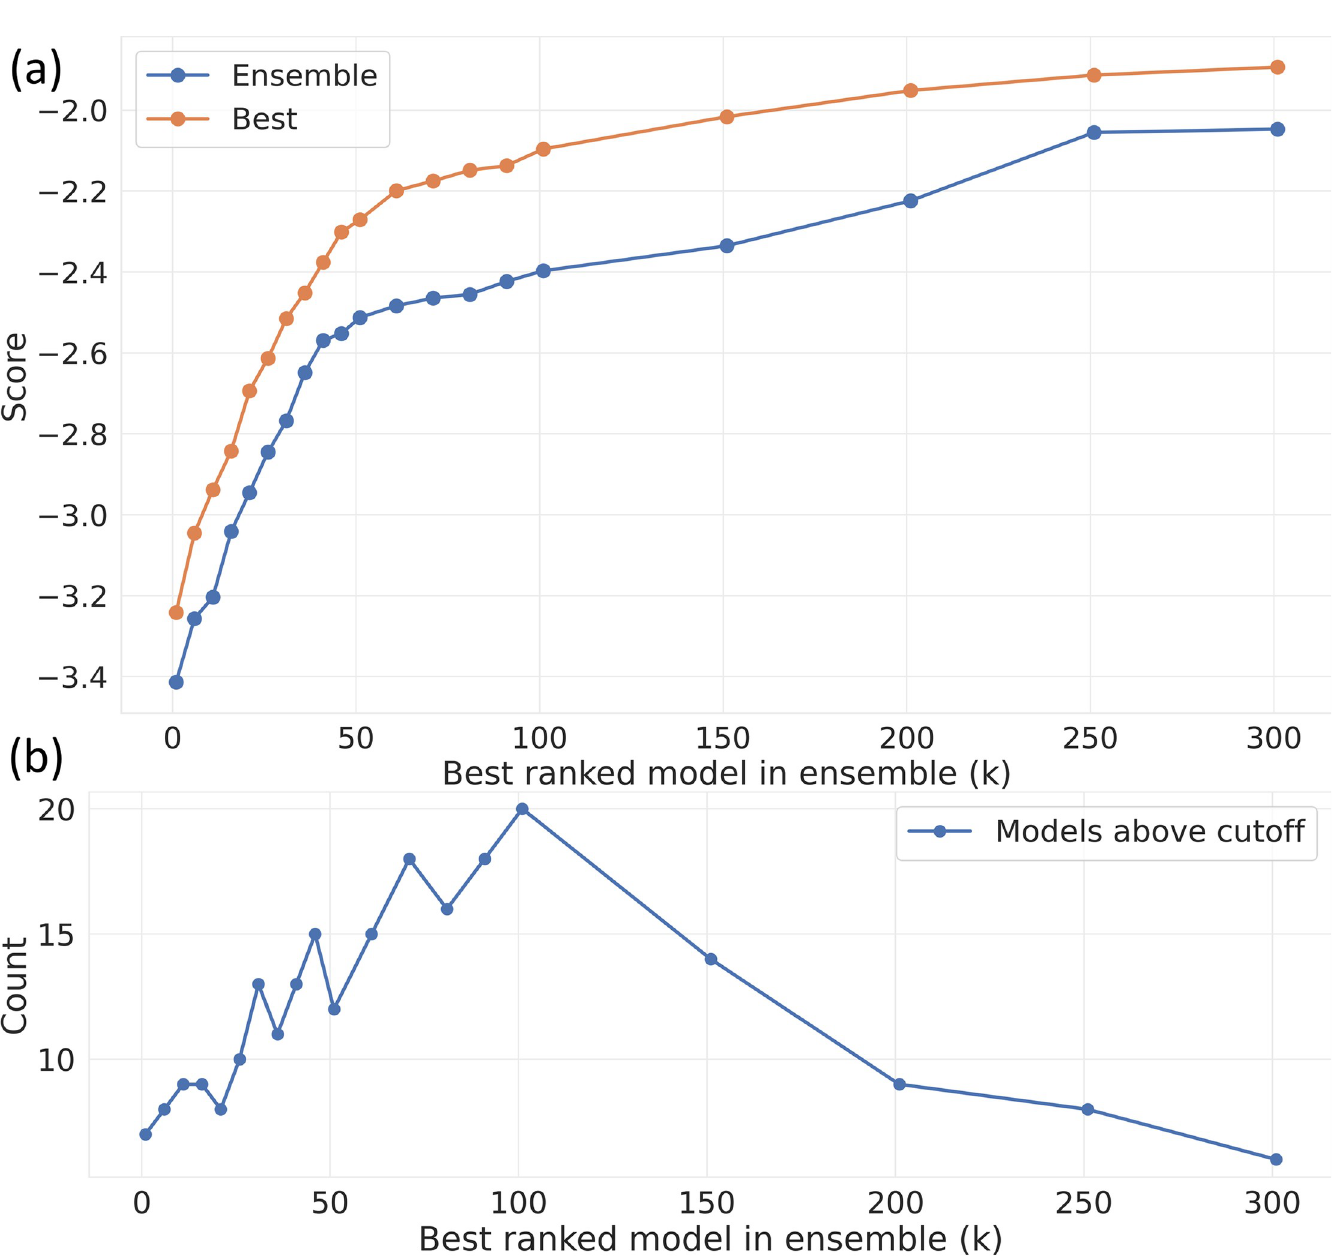
Fig 3. (a) comparison of the top individual score (orange) to the ME model score (blue) as function of the k value in Eq (2); (b) the number of contributors to the ME model at a particular k value that had an optimized weight greater than